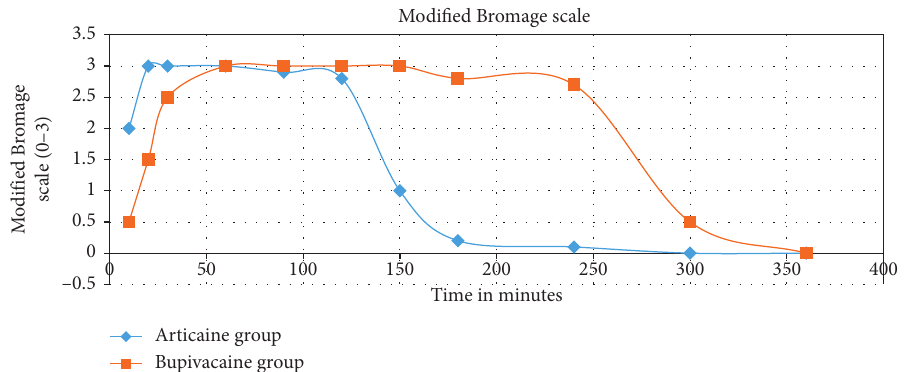
Figure 4: Modified Bromage scale showing early onset and offset of motor power in the articaine